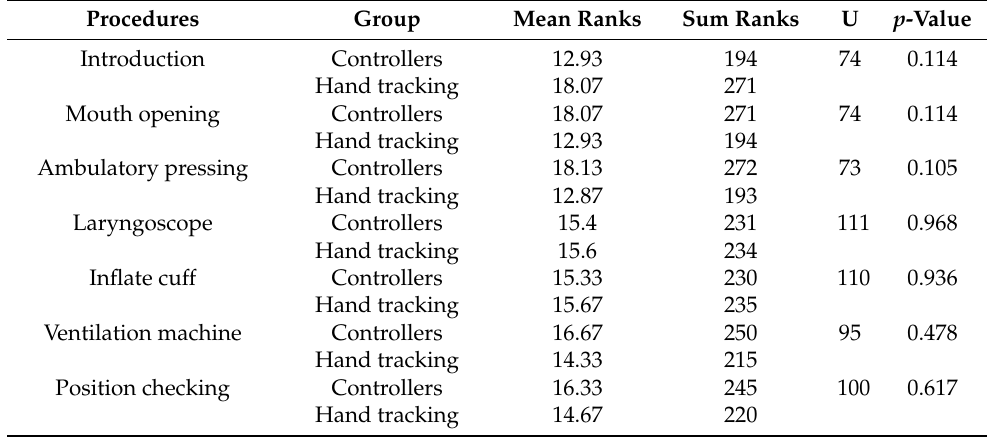
Table 7. Mann–Whitney U test results of selection and manipulation time for each procedure in VR